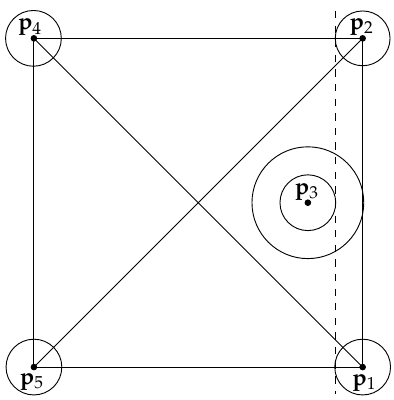
Figure 2. Five points in the plain. The radius of the bigger circle represents the minimal distance from any point to a line, the radius of the smaller circle is the maximal perturbation (MP). If points p 2 and p 3 , or points p 3 and p 1 , cross the dashed line simultaneously, the order type (OT) changes, and the figure will be an irregular pentagon instead of a square with one point inside. Points are sorted in a circular form starting with p 1